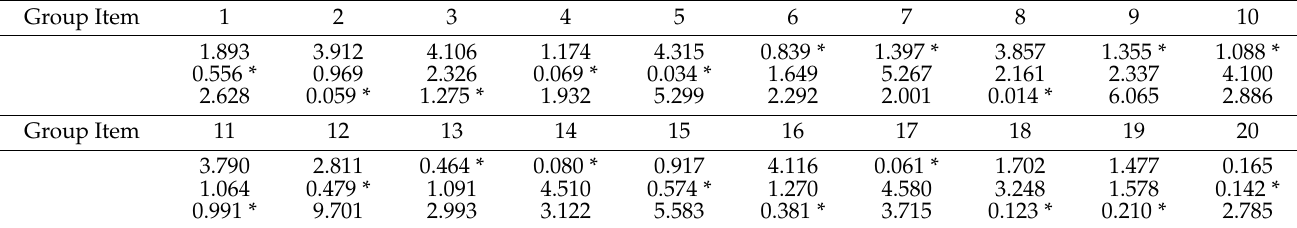
Table 4. Random grouping for the electrical appliances dataset.